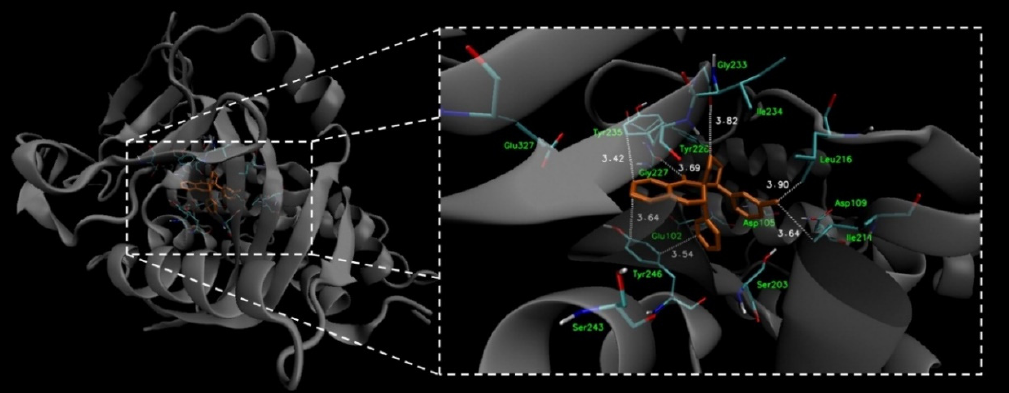
Figure 7. Docked binding mode and distances to the amino acid residues of PARP1 enzyme’s active site for compound I .